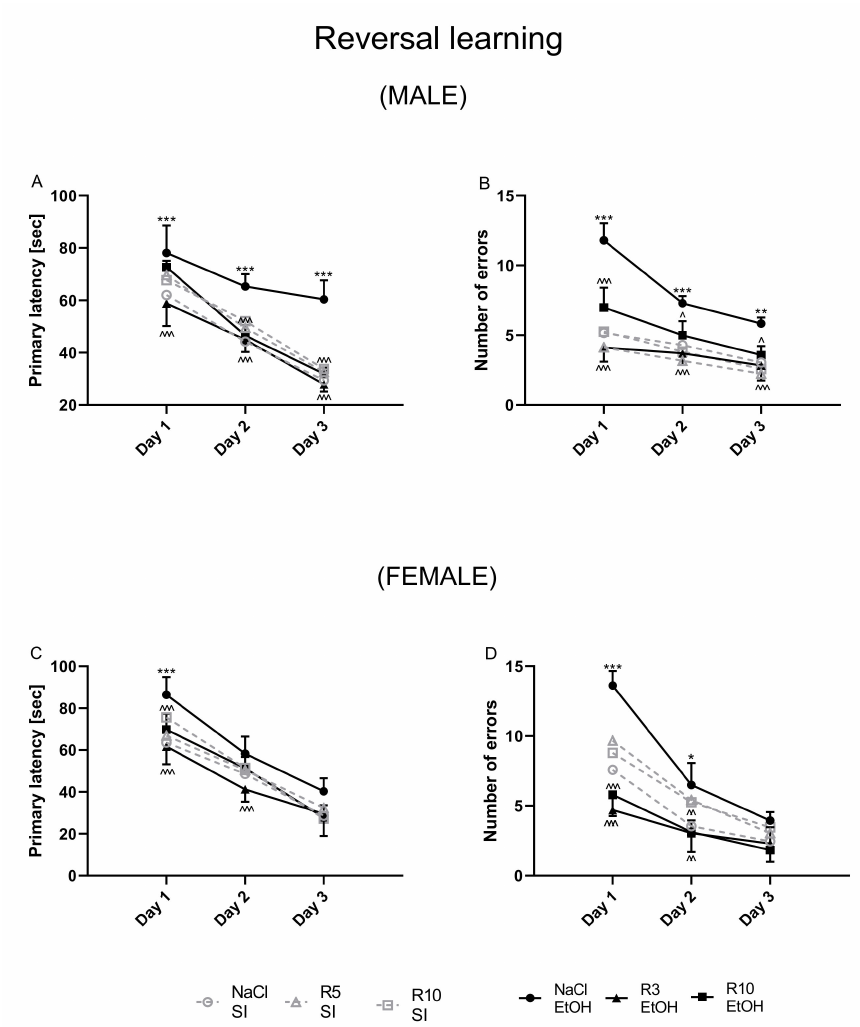
Figure 4. The influence of rapamycin pre-treatment (3 and 10 mg/kg, i.p.) during neonatal period before every ethanol administration (PND4–9) on the reversal learning impairments in adult (PND67– 69) male and female rats in the Barnes maze task. Primary latency ( A , C ) and number of errors ( B , D ) are expressed as mean ± SEM of 8 subjects per group (R 3.6.0. for Windows). * p < 0.05; ** p < 0.01; *** p < 0.001 vs. SI; ˆ p < 0.05; ˆˆ p < 0.01; ˆˆˆ p < 0.001 vs. EtOH. R3–rapamycin 3